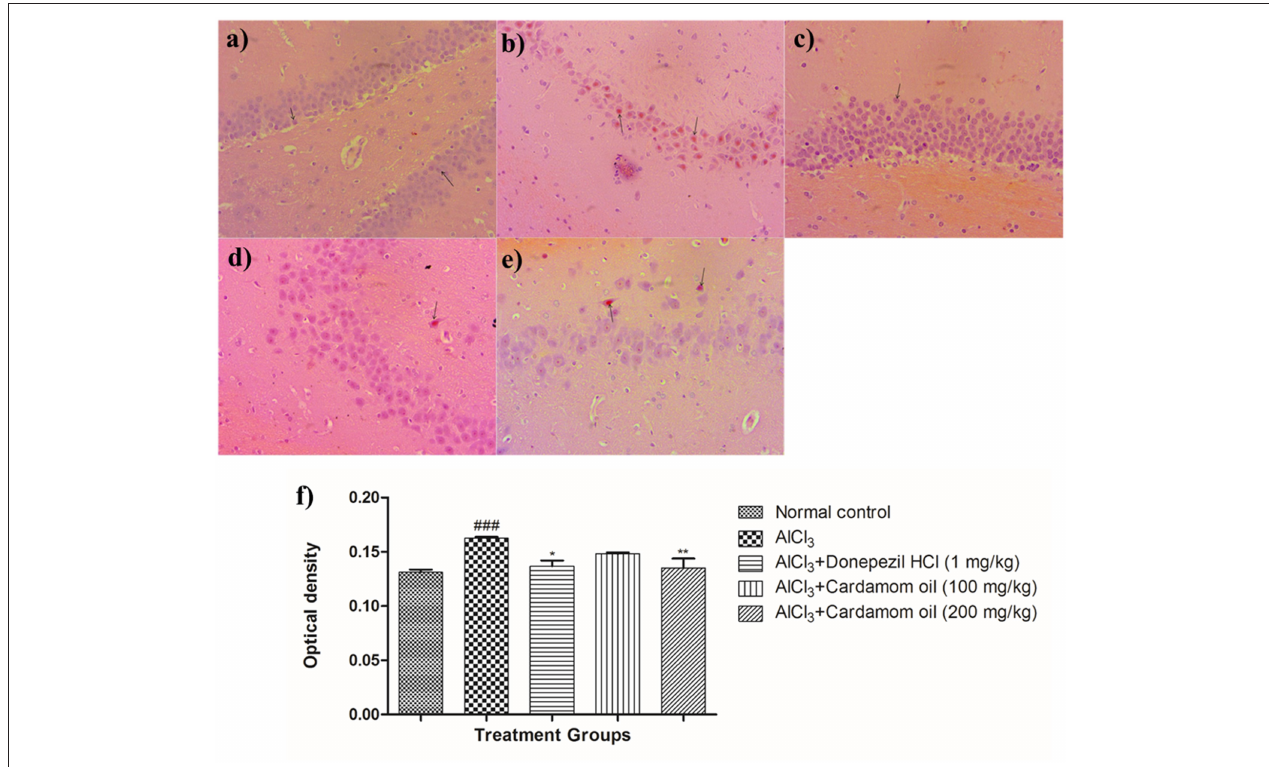
FIGURE 7 | Effect of Cardamom oil on Congo red stained hippocampus tissue (400X). (a) Normal control: Hippocampus: showing normal histology, normal neuronal cells in (small arrow) {Congo Red, 400X}, (b) AlCl 3 group: Hippocampus: showing multifocal, moderate deposition of amyloid β plaques (arrow) {Congo Red, 400X}, (c) AlCl 3 + Donepezil hydrochloride (1 mg/kg): Hippocampus: showing normal histology, normal neuronal cells (small arrow) {Congo Red, 400X}, (d) AlCl 3 + Cardamom oil (100 mg/kg): Hippocampus: showing multifocal mild deposition of amyloid β plaques (arrow) {Congo Red, 400X}, (e) AlCl 3 + Cardamom oil (200 mg/kg): Hippocampus: showing multifocal mild deposition of amyloid β plaques (arrow) {Congo Red, 400X}, (f) Histogram of congo red staining. Data are expressed as mean ± SEM ( n = 6), ### p < 0.001 when compared with normal control, ** p < 0.01, * p < 0.05 when compared with disease control group. The magnification was 400 X. AlCl 3 , Aluminum chloride; SEM, Standard Error of